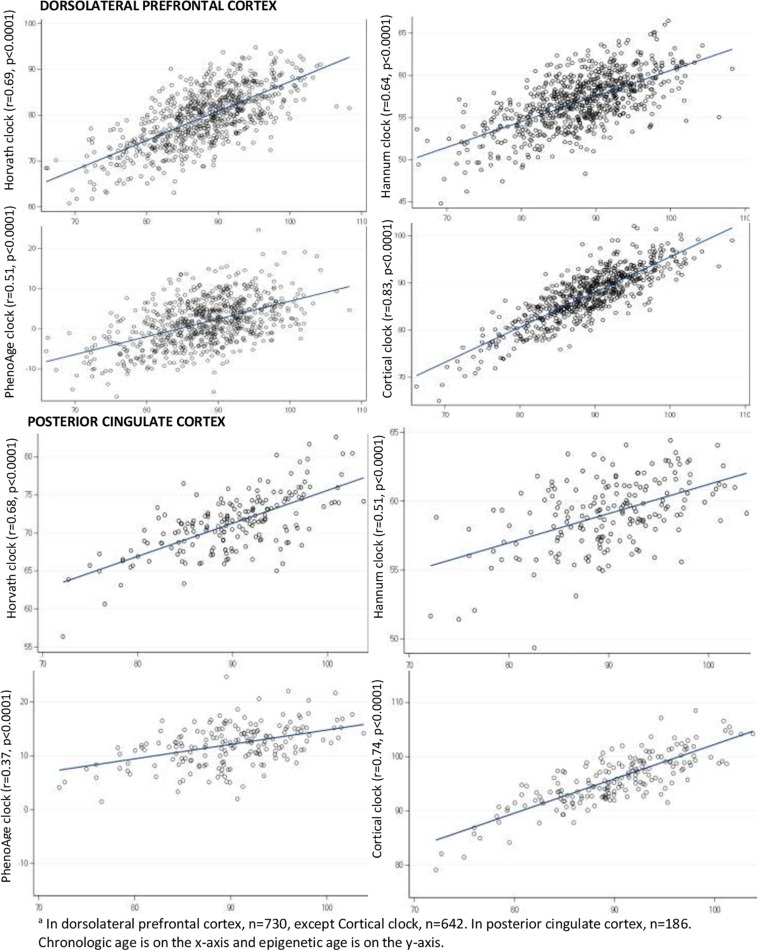
Pearson correlations of epigenetic age to chronologic age in brain specimensa.